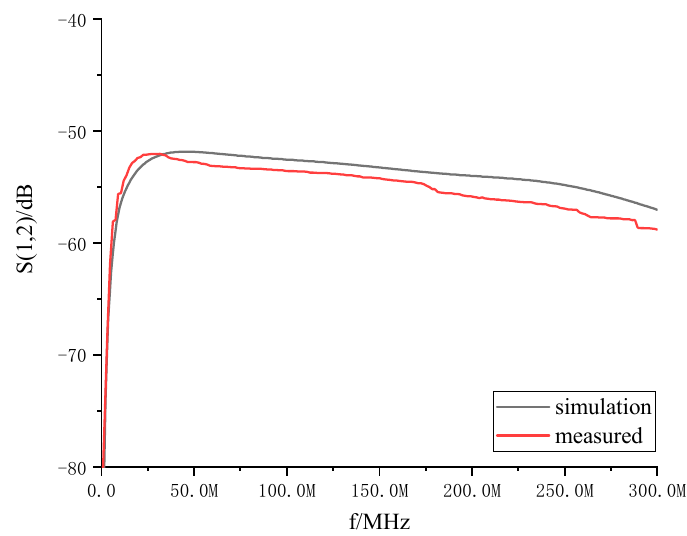
Figure 17. Comparison of test simulations of the S 11 parameters of the magnetic field probe.